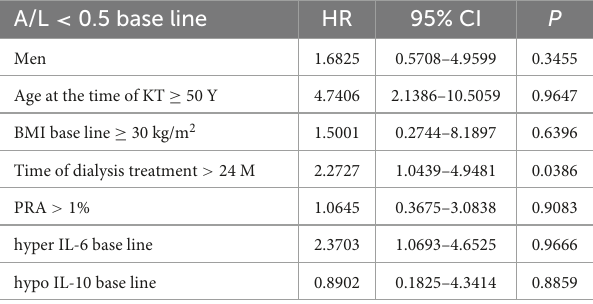
TABLE 4 Cox proportional hazard model, end point: A/L ratio < 0.5